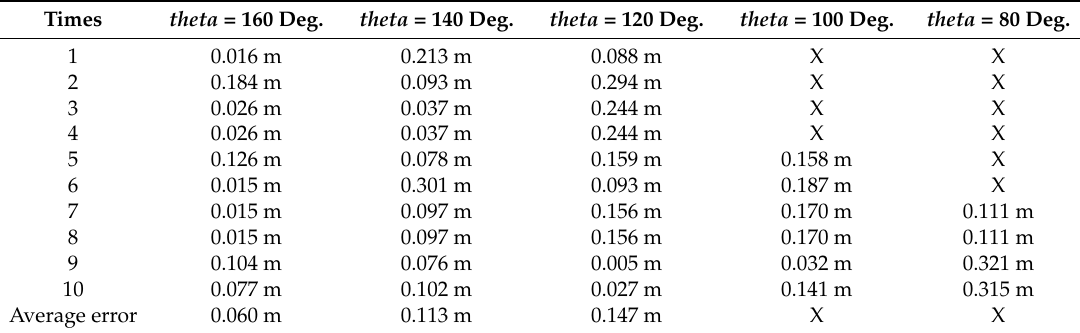
Table 2. The accuracy with different theta